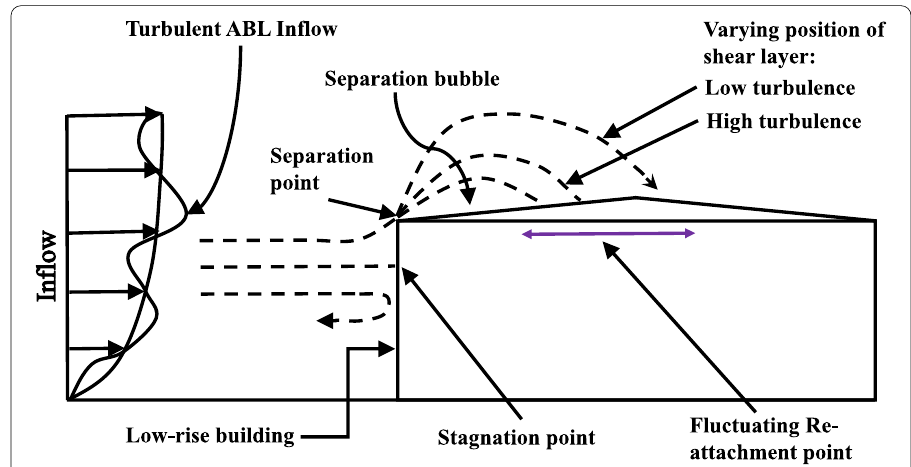
Fig. 1 Wind flow around a low-rise building (adapted from